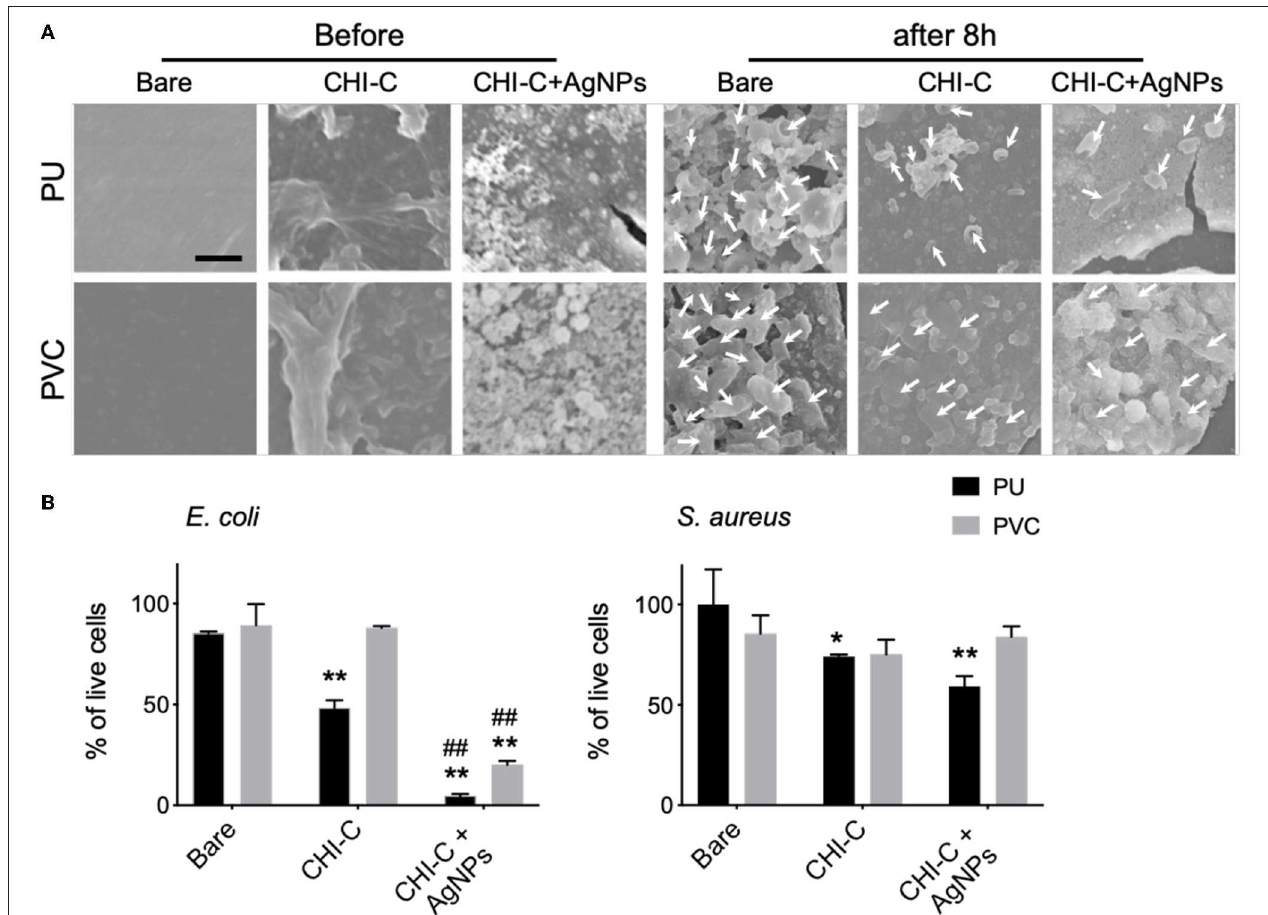
FIGURE 6 | Enhanced antibacterial adhesion effects by 6 deposition cycles of CHI-C and silver impregnated CHI-C onto the PU and PVC substrates. (A) SEM analysis was performed to validate the antibacterial adhesion effects 8h after cell seeding. The white arrows indicate E. coli . Scale bar indicates 2 µ m. (B) The adhesion of live Escherichia coli ( E. coli ) and Staphylococcus aureus ( S. aureus ) were quantified by Live/Dead BacLight Viability assay ( n = 3 * p < 0.05 and ** p < 0.01 vs. each bare substrate, ## p < 0.01 vs. each CHI-C substrate).